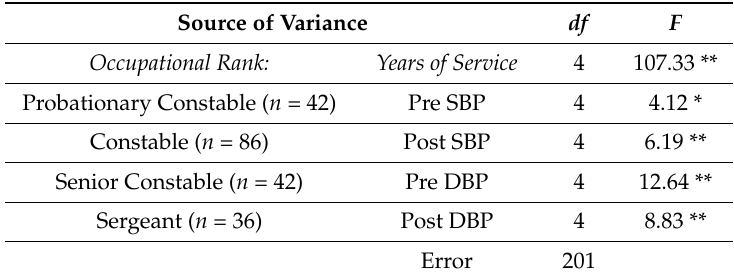
Table 3. Significant differences between police officers based on occupational rank in corrected model (MANCOVA) + . Source of Variance df F Occupational Rank: Years of Service 4 107.33 ** Probationary Constable ( n = 42) Pre SBP 4 4.12 * Constable ( n = 86) Post SBP 4 6.19 ** Senior Constable ( n = 42) Pre DBP 4 12.64 ** Sergeant ( n = 36) Post DBP 4